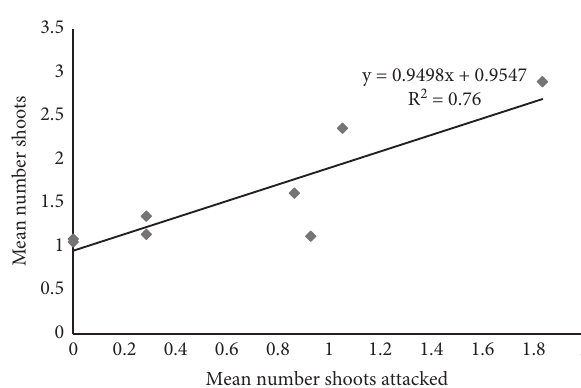
Figure 5: Relationship between the mean number of shoots and the mean number of shoots attacked for K. ivorensis in the species trial 21 months after planting in the moist semideciduous forest.